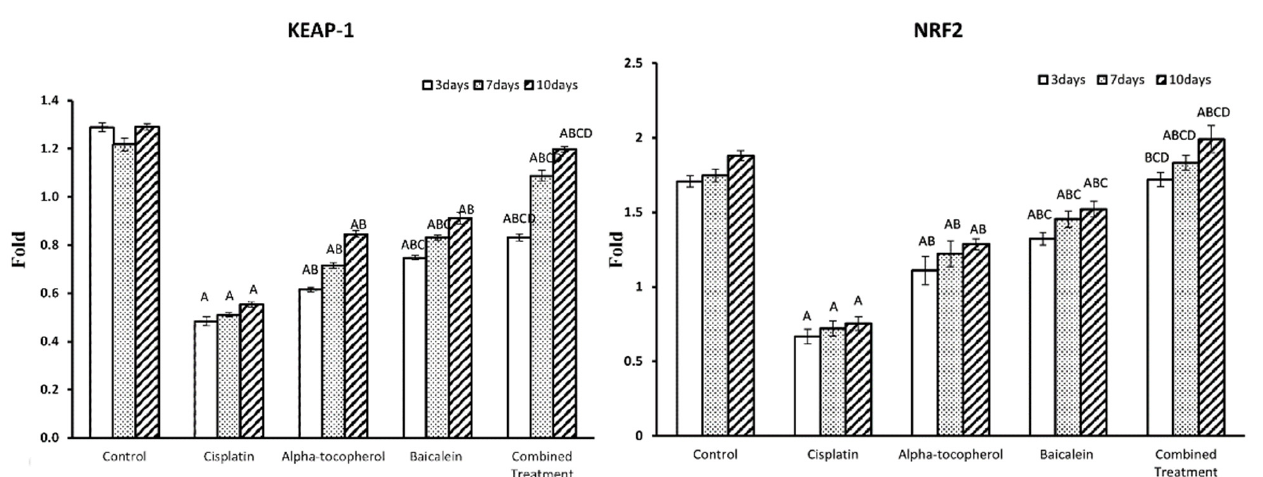
Figure 6. Effect of α -tocopherol and baicalein administration on Keap-1 and NRF-2 in control and treated groups. All data are expressed as mean ± SEM. Significant vs. control group refers to A, while significant vs. (cisplatin, -tocopherol, and baicalein) treatment groups refers to (B, C, D), respectively.